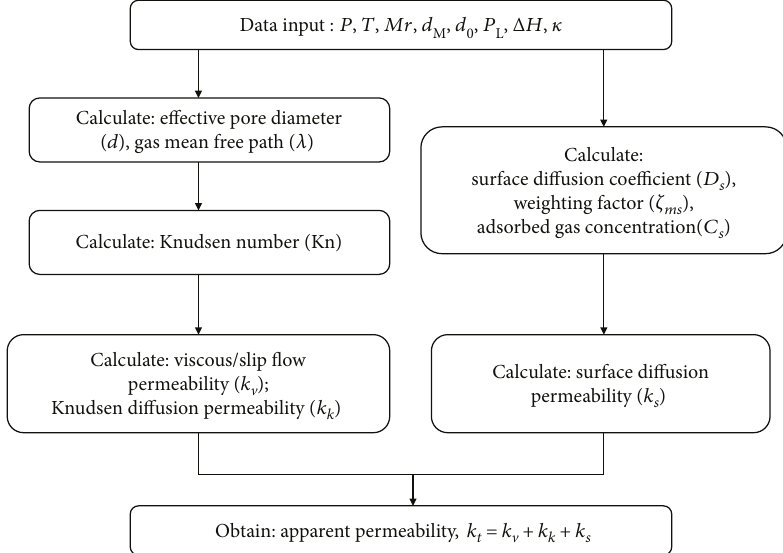
Figure 22: Procedure for apparent permeability